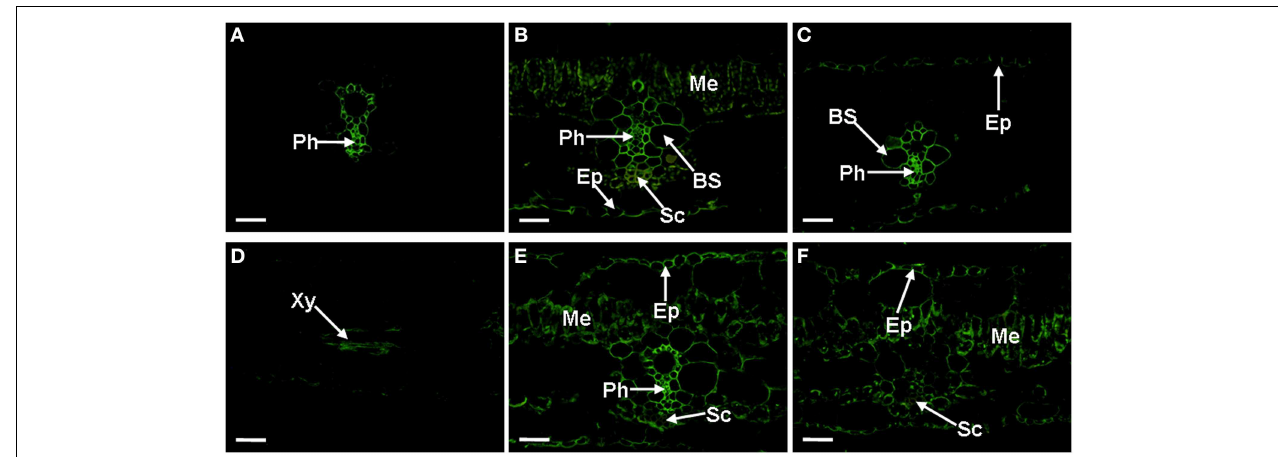
(D) Signal of JIM16 antibody, selected as the representative observed in the xylem cells between the veins for JIM4, JIM14, and JIM16 antibodies. (E) The LM2 signal, showing a strong signal appeared primarily in the vein (the phloem and the bundle sheath), a medium-strength signal in the mesophyll cells and the epidermal cells. (F) The LM14 signal, showing signal appeared primarily in the mesophyll cells, the epidermal cells and the phloem but not in the vein. AGPs, arabinogalactan proteins; BS, bundle sheath; Ep, Epidermis; Me, mesophyll; Ph, phloem; Sc, sclerenchyma cells; and Xy, xylem vessel. The bar represents 50 µ m.